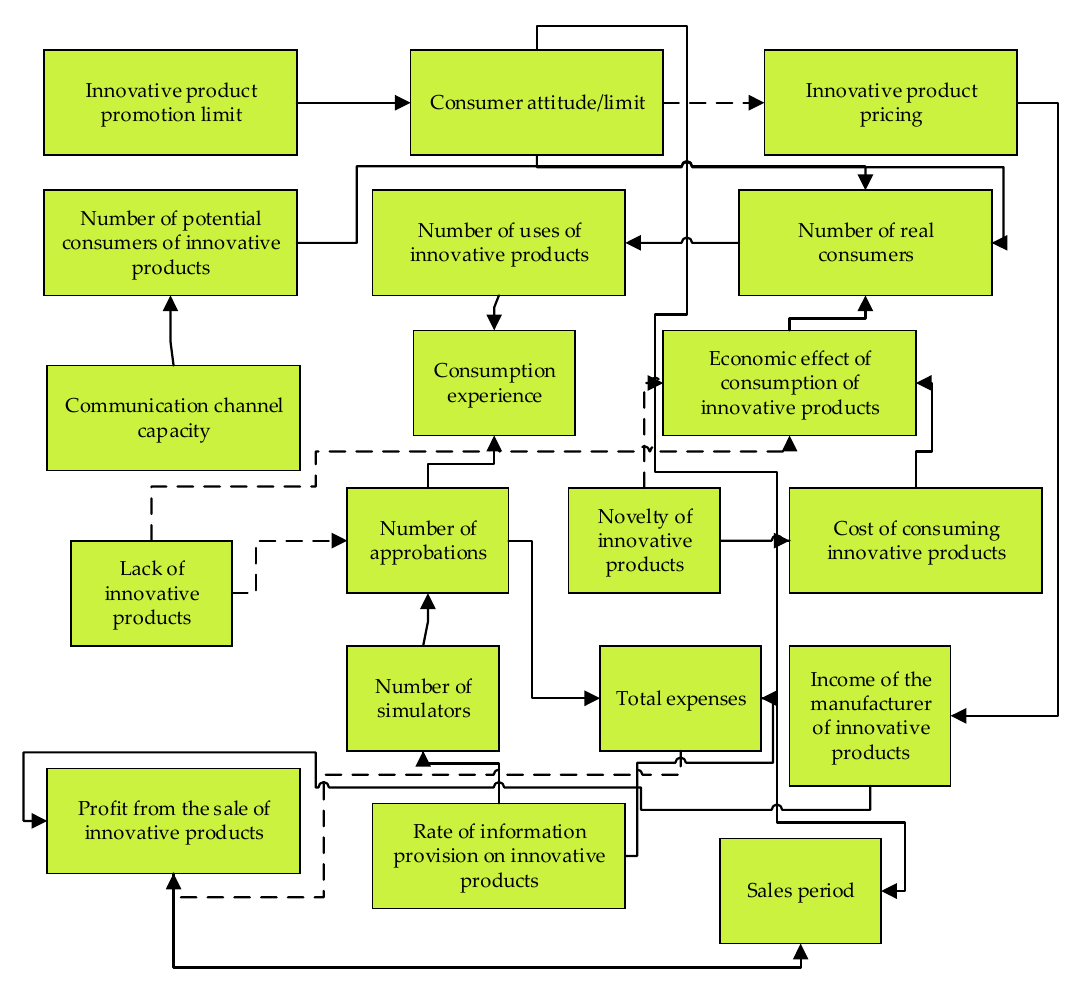
Figure 2. Diagram of causal relationships of diffusion of innovative products (author’s research). —negative relationship. —positive relationship.